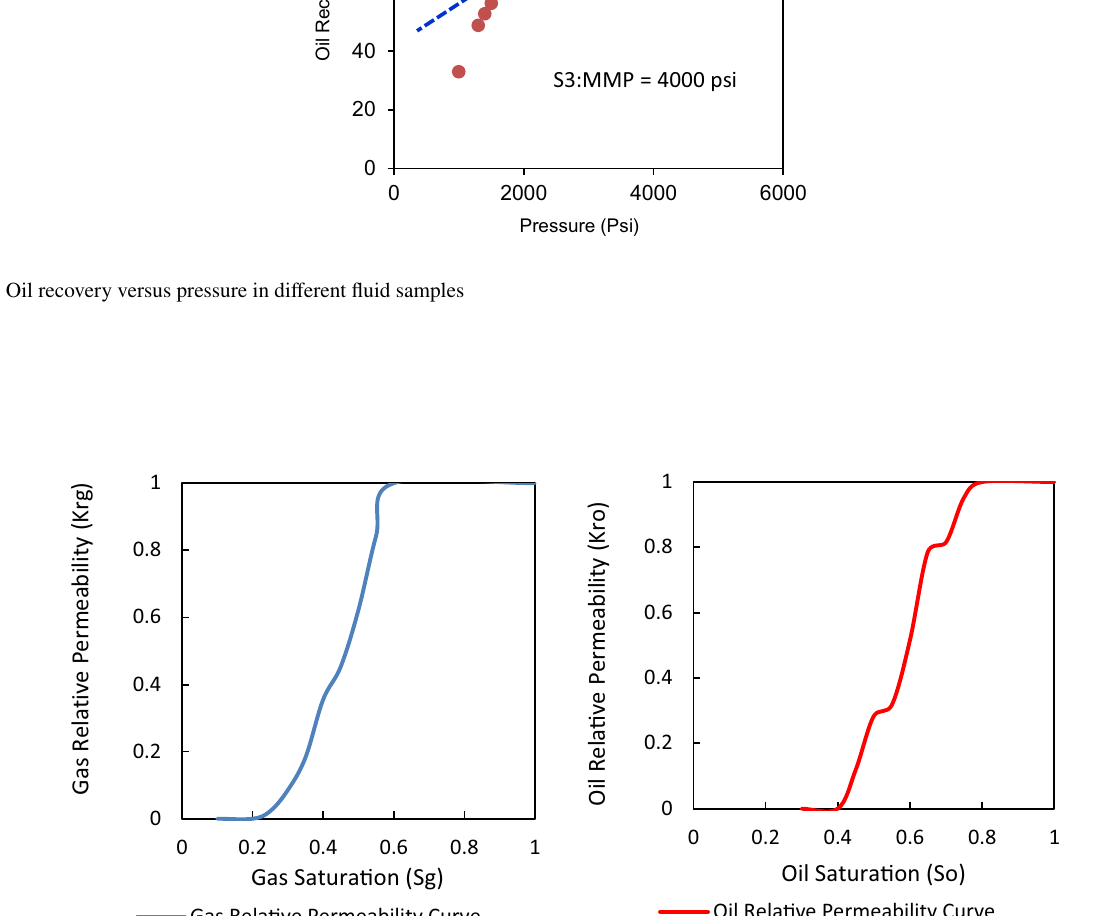
Fig. 7 Relative permeability curves used in this